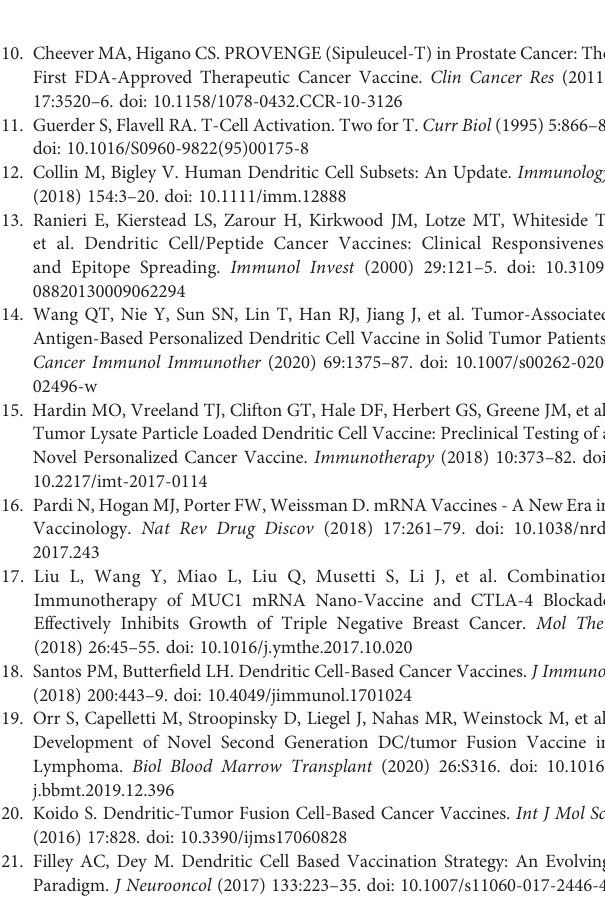
Supplementary Figure 1 | Flow cytometry analyses of the nucleic acid in FC and FCM. Flow cytometry analyses of the Hoechst 33342 stained FC and FCM. Supplementary Figure 2 | Flow cytometry analyses of the activation of T lymphocytes.TheexpressionofCD8andCD4ofTlymphocytesincubatedwithNPs, CCM@NPs, DCM@NPs and FCM@NPs for 48 h was determined by fl ow cytometry. Supplementary Figure 3 | The activation effect on DCs of FCM@NPs with CpG is better than that without CpG. (A) DCs maturation rates after the stimulation of with and without CPG-carrying vaccines. (B) Secretion of TNF- a and IL-6 of DCs treated with different vaccines. Supplementary Figure 4 | Changes of tumor size in PDX tumor model mice. Changes of the tumor size of P 1 DX and P 2 DX in PBS, NPs, P 1 DFCM and P 2 DFCM